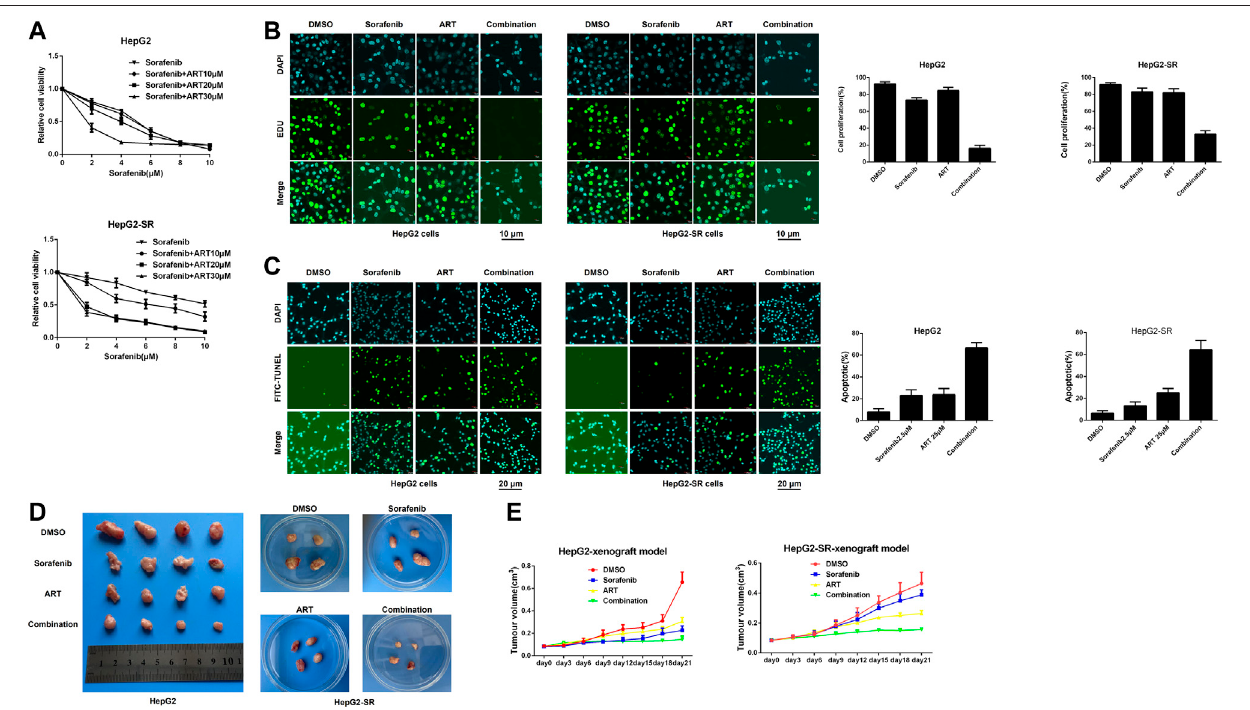
FIGURE 5 | Artesunate (ART) combined with sorafenib overcomes adaptive resistance to sorafenib in vitro and in vivo . (A) . Cells were treated with sorafenib alone or in combination with a fi xed dose of artesunate, then MTT assays were conducted after 48 h. (B) . Sorafenib and artesunate alone or in combination were used in HepG2cellsandHepG2-SRcellsafter24 h,andcellproliferationwasdetectedviaEDUassays.Scalebars (cid:2) 10 μ m. (C) .HepG2-SRcellsandHepG2cellsweretreated with sorafenib and artesunate alone or in combination for 48 h, then apoptosis was detected via FITC-TUNEL staining assays. Scale bars (cid:2) 20 μ m. (D) . ∼ 1 × 107 HepG2 or HepG2-SR cells were injected into mouse fl anks. When tumors reached ≥ 100 mm 3 in size the mouse was administered (1) DMSO with corn germ oil, (2) sorafenib(30 mg/kg)withcorngermoil,(3)artesunate(50 mg/kg)withcorngermoil,or(4)sorafenib(30 mg/kg)andartesunate(50 mg/kg)withcorngermoilonceevery 3 days via oral cannular. Tumor sizes were measured periodically with calipers, and tumor volumes were calculated using the formula volume (cid:2) (width 2 × length)/2. (E) . After 21 days mice were killed by cervical dislocation, and the tumors were removed and weighed. Experiments were repeated three times.